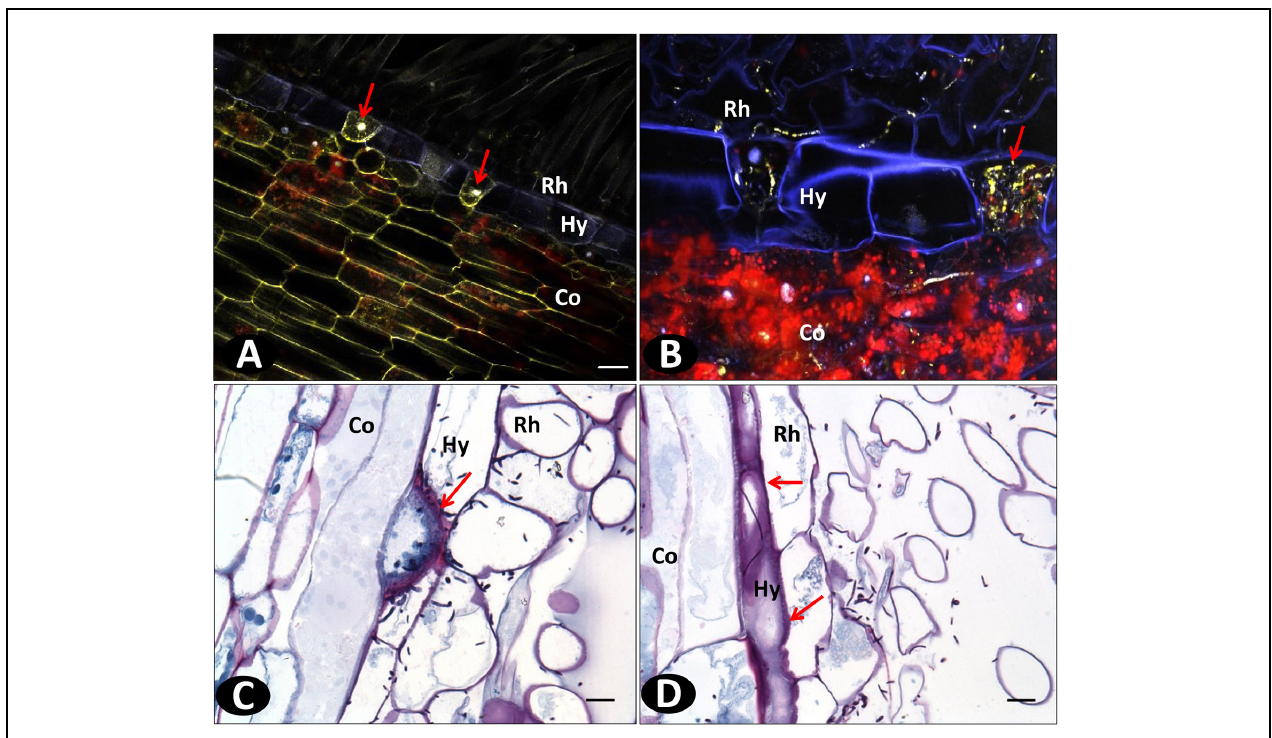
FIGURE 7 | Histopathological defense responses of resistant accessions infected with Fo072. (A,B) Multiphoton images showing the formation of “globular” structures (pointed with arrows) on the hypodermal cells (Hy) entrapping the hyphae and preventing their further colonization to the cortical region (Co) of pom0018 infected with Fo072 at 4 dpi; (C,D) WFM images of infected root samples double-stained with Schiff reagent and Napthol Blue-black stain, showing the defense response of hypodermal cells (denoted with arrows) with (C) showing intense staining of hypodermal cell walls of pla0020 and (D) the formation of dark layered hypodermal cells between the rhizodermis (Rh) and cortex (Co) in pom0018 infected with Fo072 at 8 dpi. The pink color dark staining reveals the deposition of polysaccharides in the cell walls of hypodermis. Scale bar = 20 μ